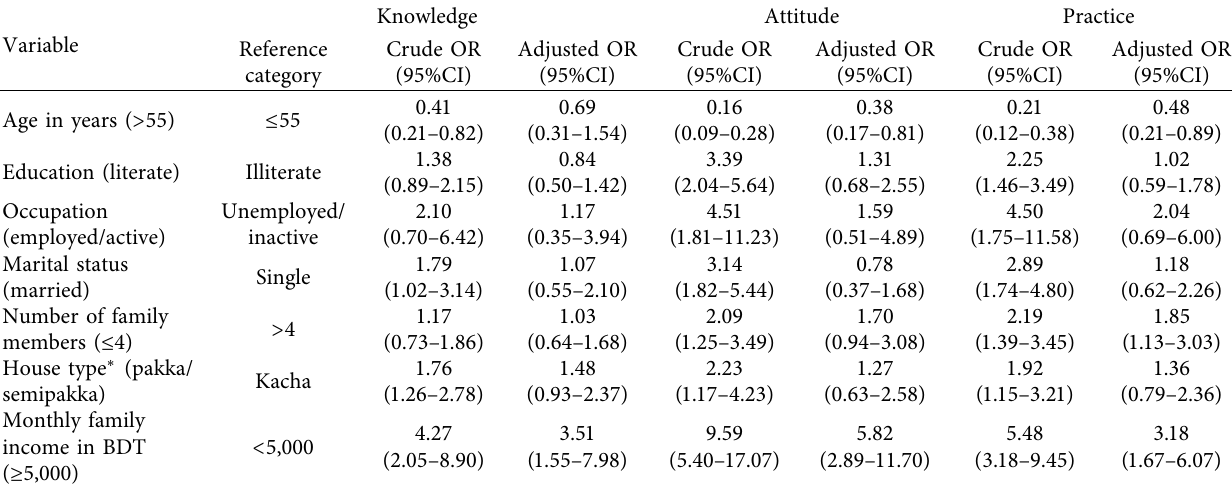
Table 6: Univariate and multivariable logistic regression analysis exploring factors associated with good knowledge, attitude, and practice among